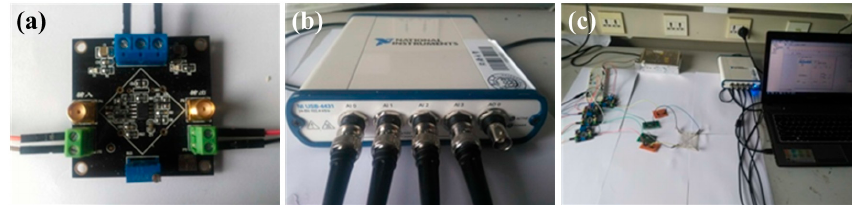
Figure 3. Measurement system of the touch panel. ( a ) OPA129 amplifying system; ( b ) NI-4431 four-channel data acquisition board; ( c ) The overall measurement system.